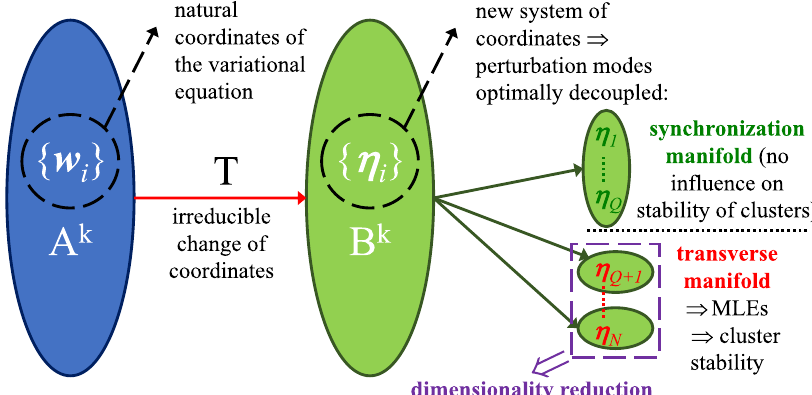
Fig. 3 Dimensionality reduction based on the transformation matrix T . First (blue oval), the system is linearized about a synchronous solution s ( t ) (composed of Q distinct synchronized motions), in order to analyze the dynamics of a small perturbation w i ( t ) around each node i ( i = 1, … , N ); the topology of each network layer is described by an adjacency matrix A k . Second (large green oval), the transformed system is described by a new set of coordinates { η i }, which are coupled through the matrices B k = TA k T − 1 . The new coordinates are decoupled into two sets (small green ovals), one containing the perturbations lying on the synchronization manifold, which do not affect the stability of the synchronized clusters, and one containing the perturbations transverse to the synchronization manifold, which affect the stability of the synchronized clusters. In particular, we look for the irreducible change of coordinates (and corresponding matrix T ), which decouples the transverse perturbation modes as much as possible (green ovals within the dashed purple box). The transverse perturbation modes contain information on the stability of clusters, also evidencing the presence of interdependencies between different